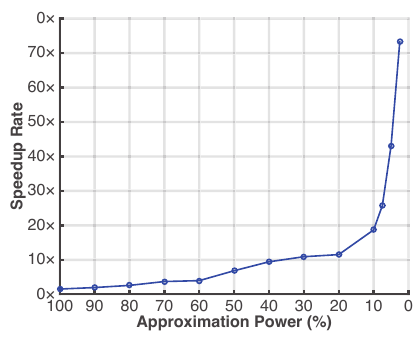
Figure 10. Speedup rate of CPAR with Different Accuracy Compared with oper- KL oper- KL